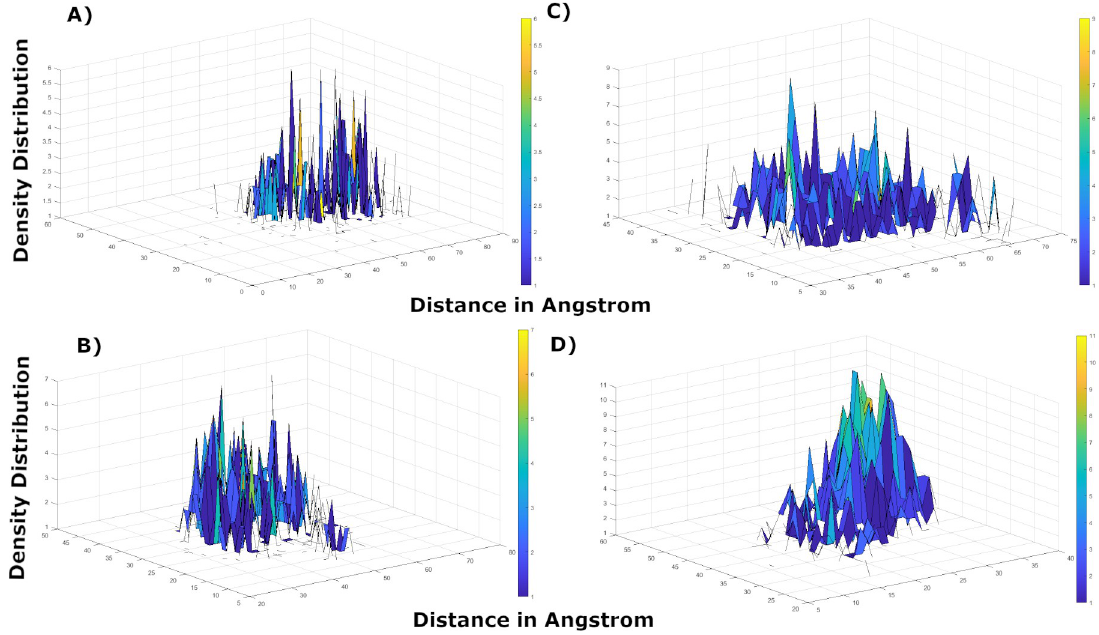
Fig 10. AFD plots to compare point of coordinates and geometry between the active phytochemicals a) Hesperetin at 10 ns, b) Hesperetin at 200 ns, c) Xanthoangelol_E at 10 ns, d) Xanthoangelol_E at 200 ns, e) Vizimpro at 10 ns, and f) Vizimpro at 200 ns.